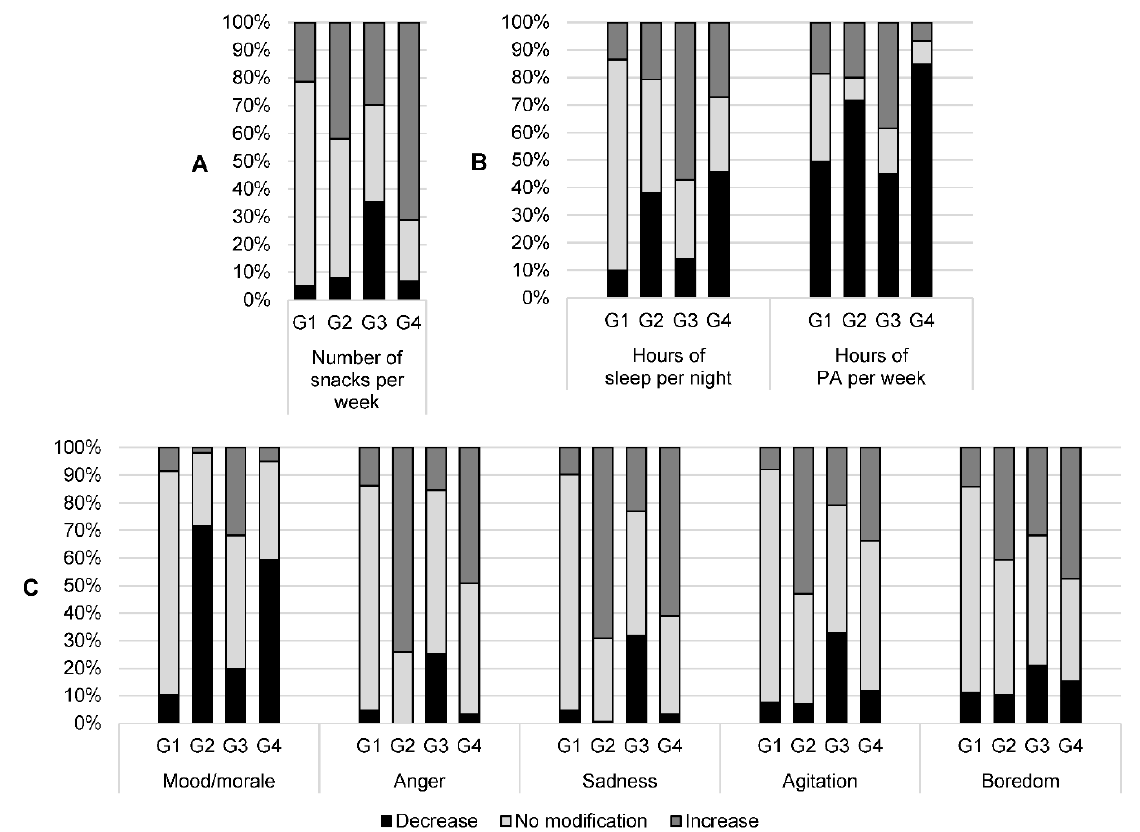
Figure 4. Description of changes in consumption, lifestyle, and mood before and during the first lockdown, according to the four groups obtained after multiple correspondence analysis. ( A ) Number of snacks; ( B ) sleep and physical activity; ( C ) quality of life and mood. Black bars represent participants who reported a decrease during the first lockdown compared to before; light-gray bars represent participants who reported no modification during the first lockdown compared to before; dark-gray bars represent participants who reported an increase during the first lockdown compared to before. For the number of snacks per week, a change (increase or decrease) was defined when the number was not the same before and during the first lockdown. For the number of hours of sleep per night, a change (increase or decrease) was defined when there was a difference of at least one hour before and during the first lockdown. For the number of hours of physical activity per week, a change (increase or decrease) was defined when there was a difference of at least 30 minutes before and during the first lockdown. For the other variables (visual analogue scales of feelings), the dis- tributions of the variations were divided into three parts, each containing approximately one third of the sample, to classify participants into decrease/no modification/increase. G1 to G4: Group 1 to Group 4; PA: physical activity.